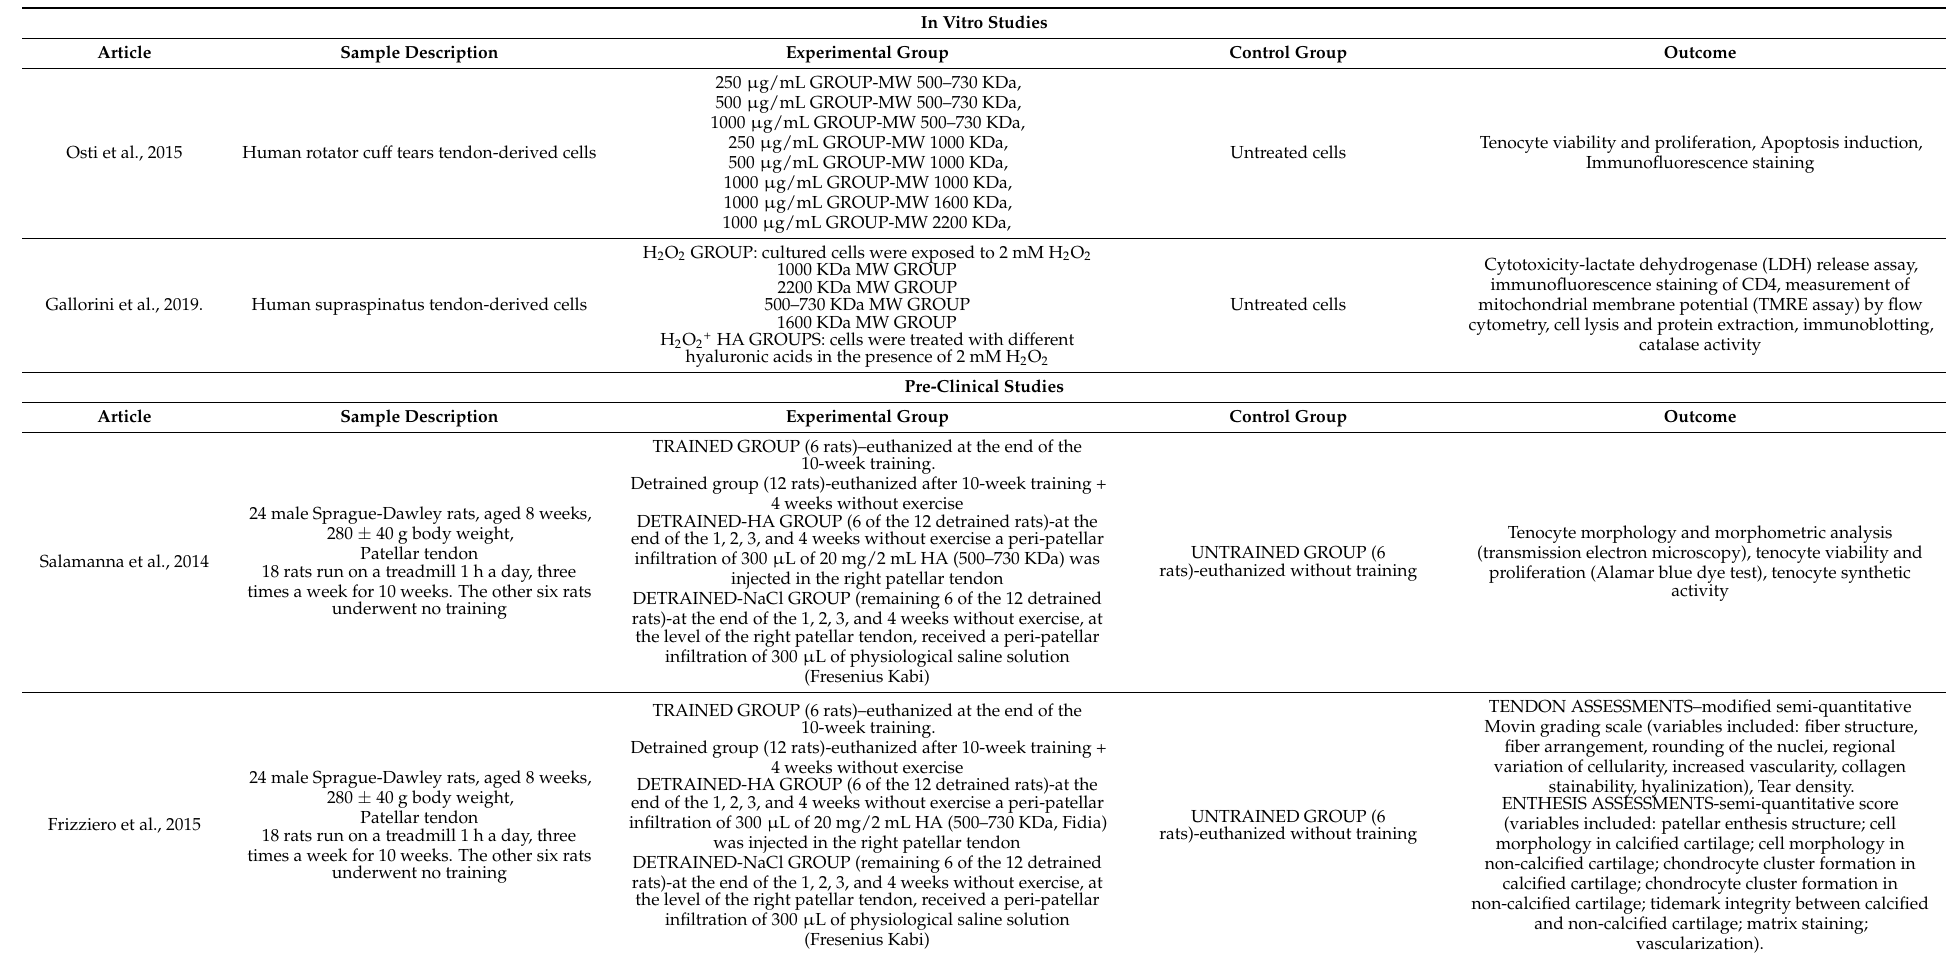
Table 1. Four papers were retrieved from literature search. Among them, 2 in vitro studies, 2 pre-clinical studies were